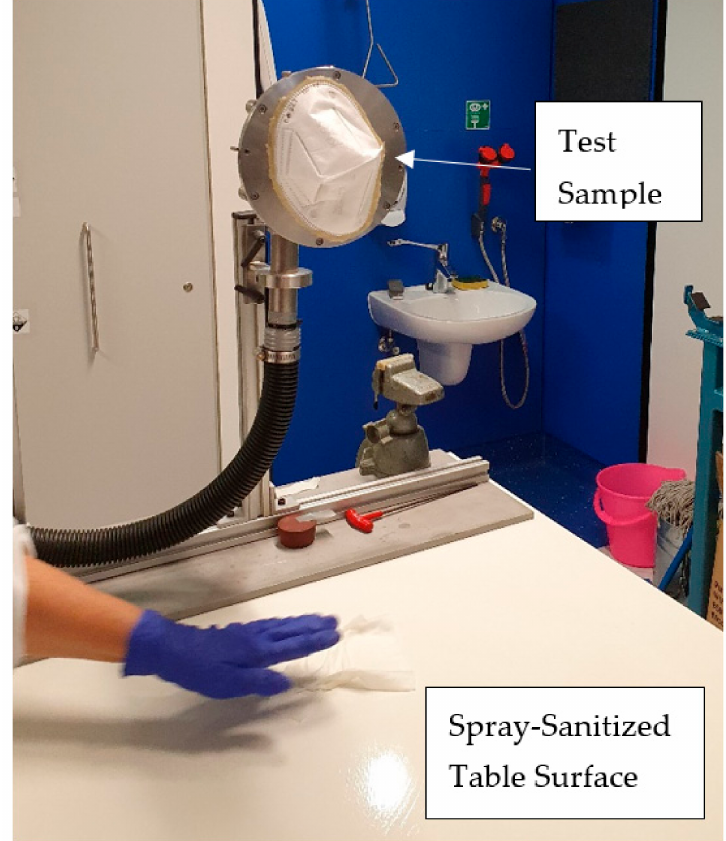
Figure 3. Experimental set up for exposing respirator test samples to alcoholic vapors (IPA) emitted by the process of spraying alcohol solution on a table surface followed by wiping with a paper towel.